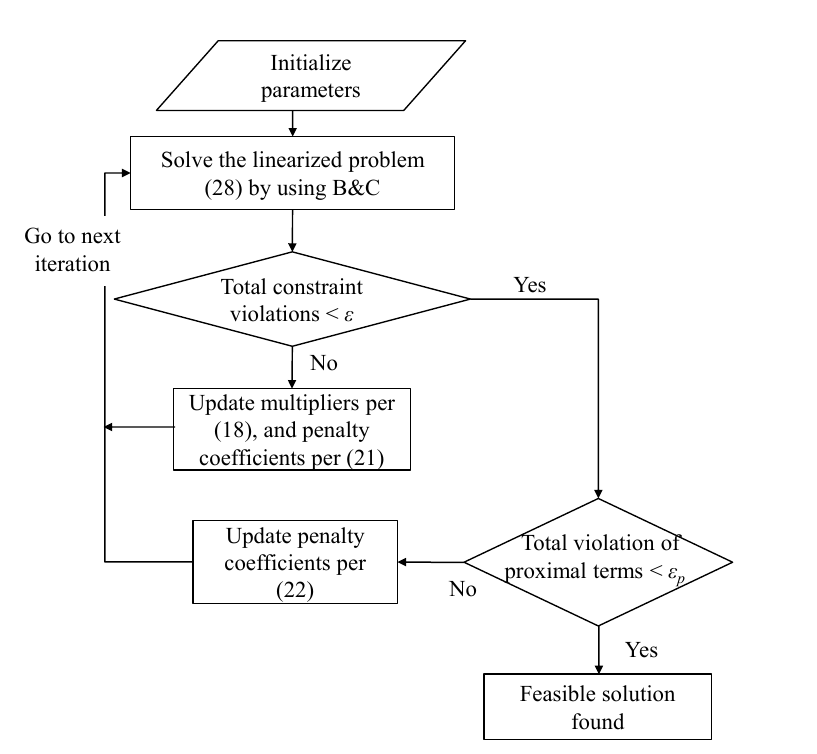
Figure 2. Surrogate Lagrangian